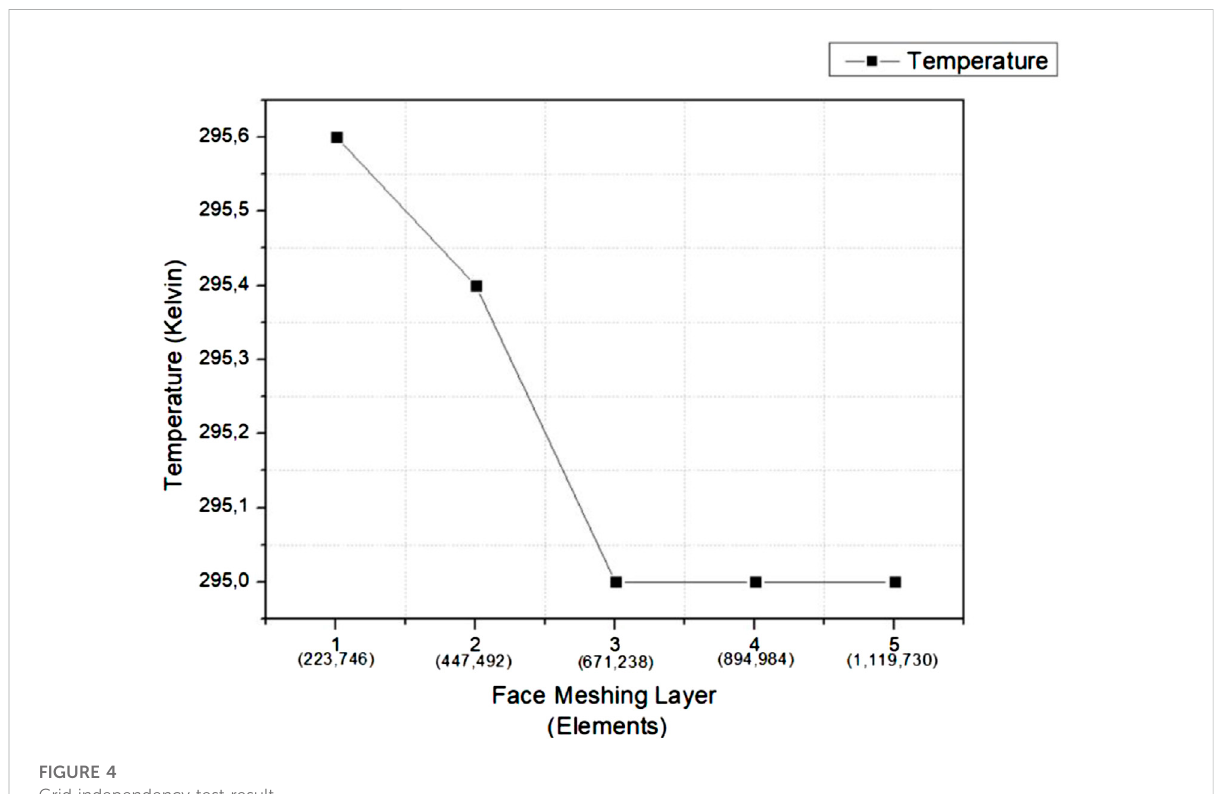
FIGURE 4 Grid independency test result.